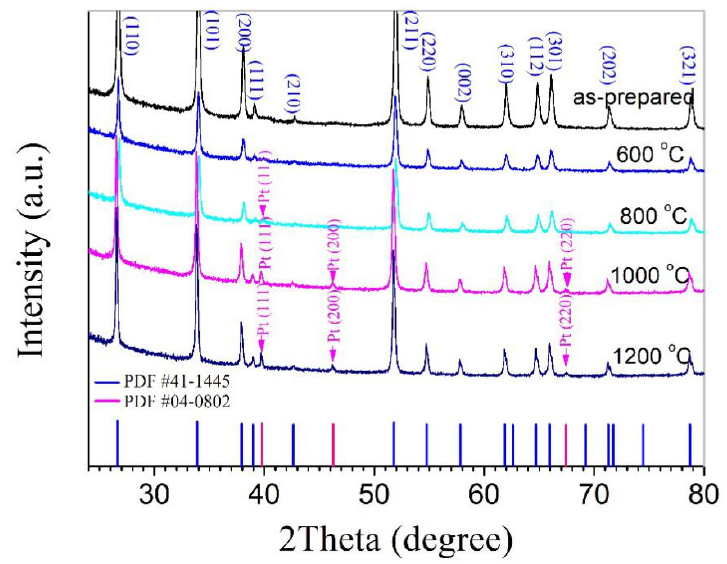
Figure 1. XRD patterns taken for a dried powder mixture of Pt and SnO 2 nanoparticles with 2.50 wt% Pt as well as pellets prepared from this powder and sintered at 600, 800, 1000, and 1200 °C, separately.